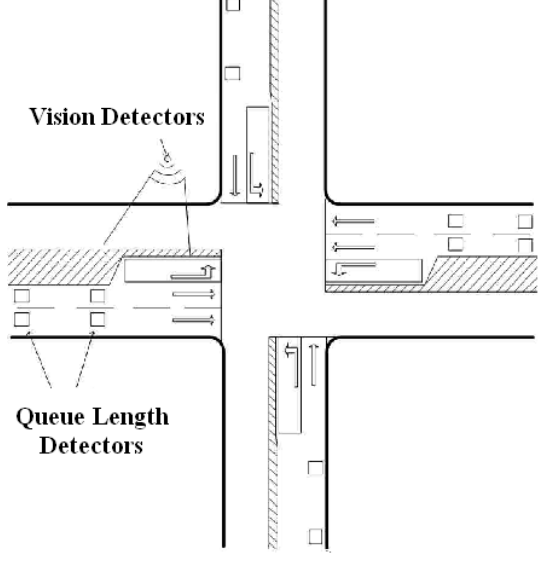
Figure 2. An intersection with typical detectors and lane configura- tion For each intersection a two-phase signal is adopted. In a cycle, each leg goes through two time intervals, the green interval during which vehicles on this leg can pro- ceed through the intersection, and the red interval. Fig.3 shows the diagram for a two-phase signal.